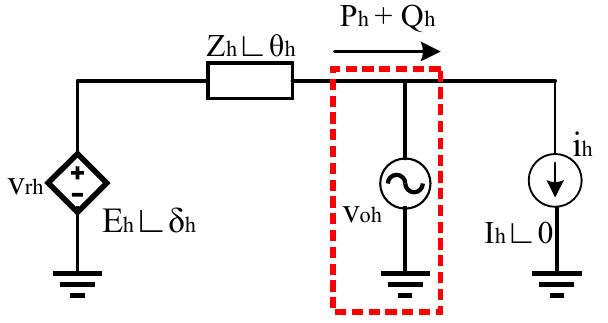
Figure 9. Inverter-based DG equivalent circuit connected to the load.